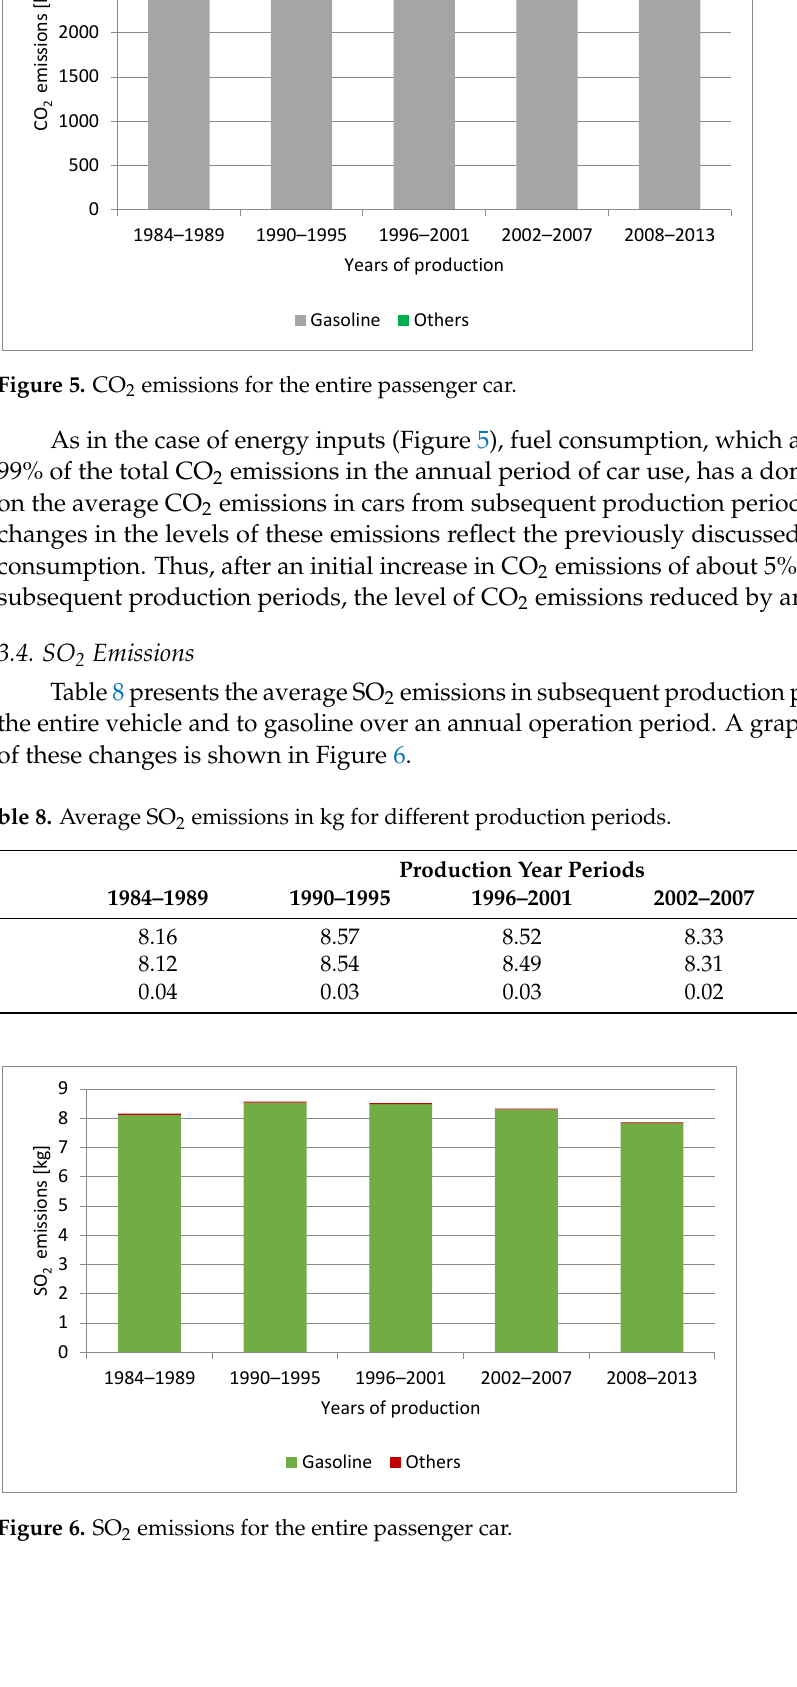
Table 7. Average CO 2 emissions in kg for different production years.